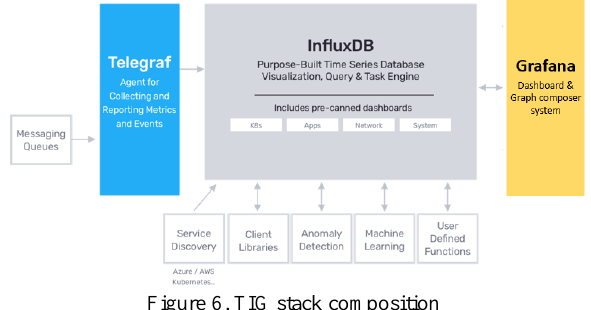
Figure 6. TIG stack